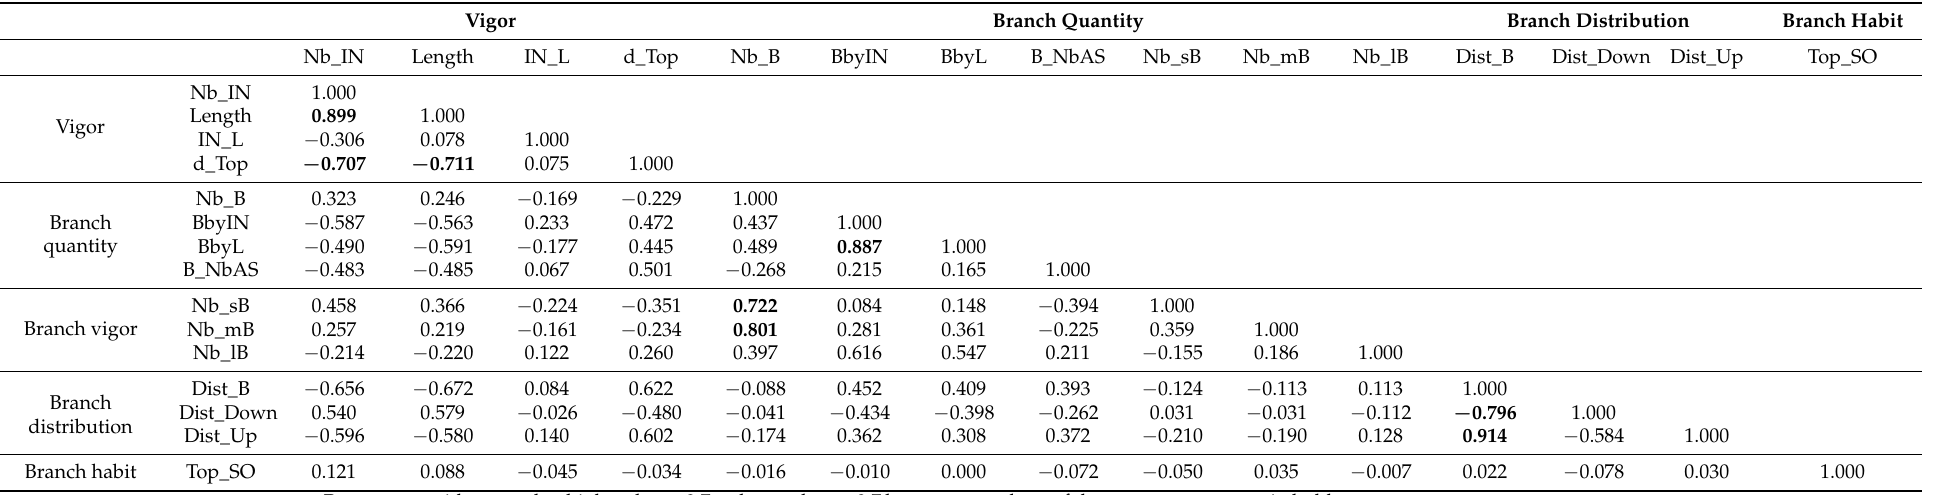
Table 3. Pearson’s correlation coefficients of variables comparing 30 almond scion–rootstock combinations, classified by which aspect of almond tree architecture they affect and selected by rootstock influence. Refer to Table 1 for